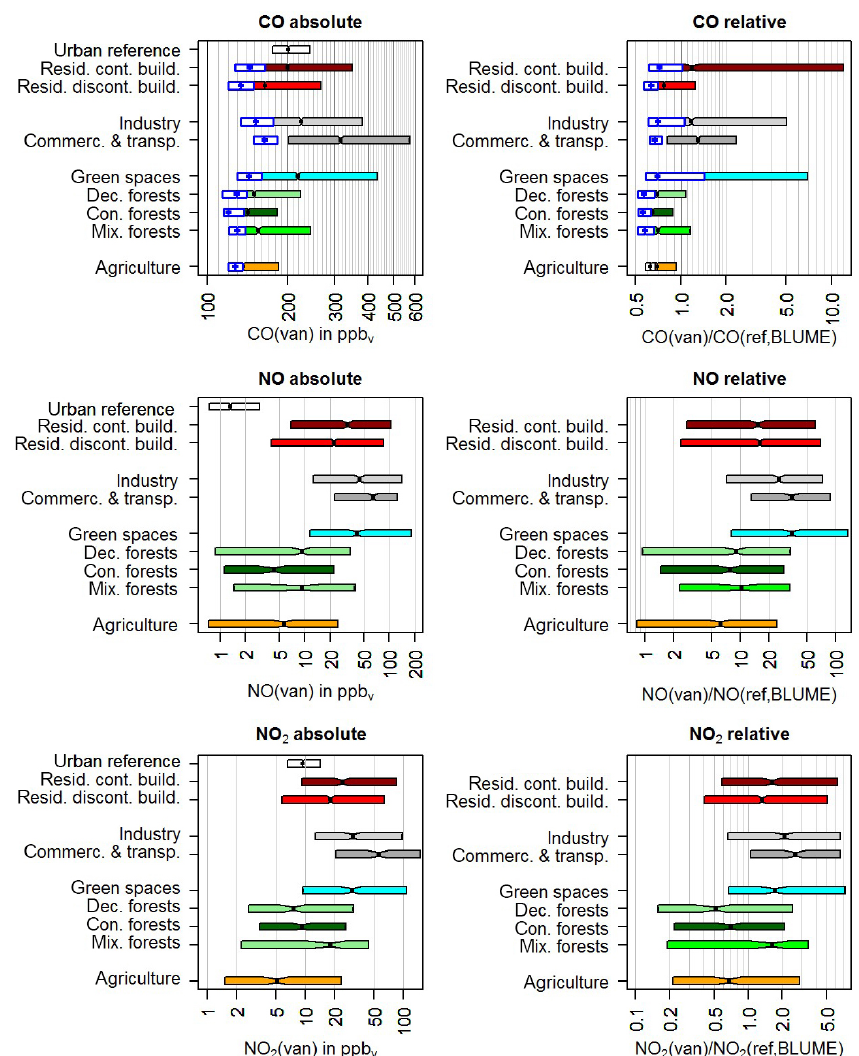
Figure 8. Box plots of CO, NO and NO 2 mobile measurement values (left graphs) and ratios of mobile measurements relative to Neukölln (right graphs) in areas of different land use (CORINE). The box plots start and end at the 25th and 75th percentile with a notch between the 45th and 55th percentiles. Blue outlined transparent bars in the CO graphs refer to the so-called baseline values, while the colored bars represent all the observations. Shaded bars indicate an insufficient number of data points. Values and number of corresponding values are given in the supporting online information